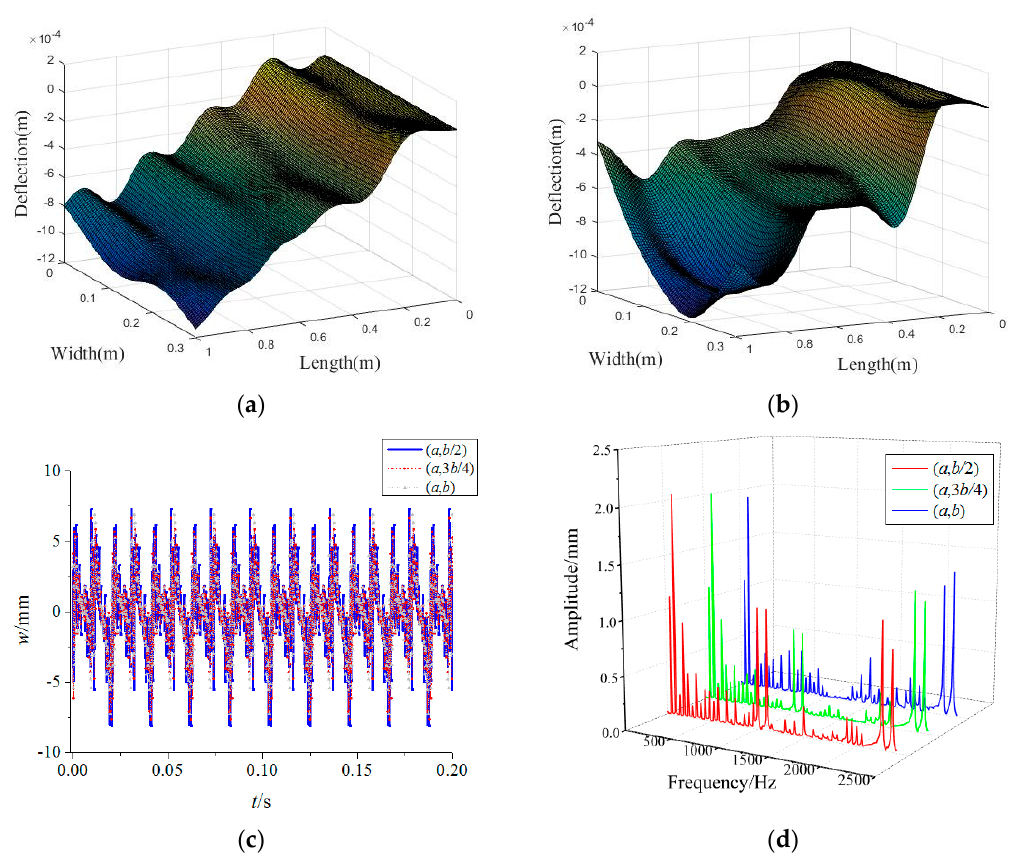
Figure 6. Effects of rub-impact locations on forced vibration responses of the rotating FGM plate ( a ) ( ξ , η ) = ( a ,3 b /4), ( b ) ( ξ , η ) = ( a , b ), ( c ) time-domain response, ( d ) frequency-domain response.